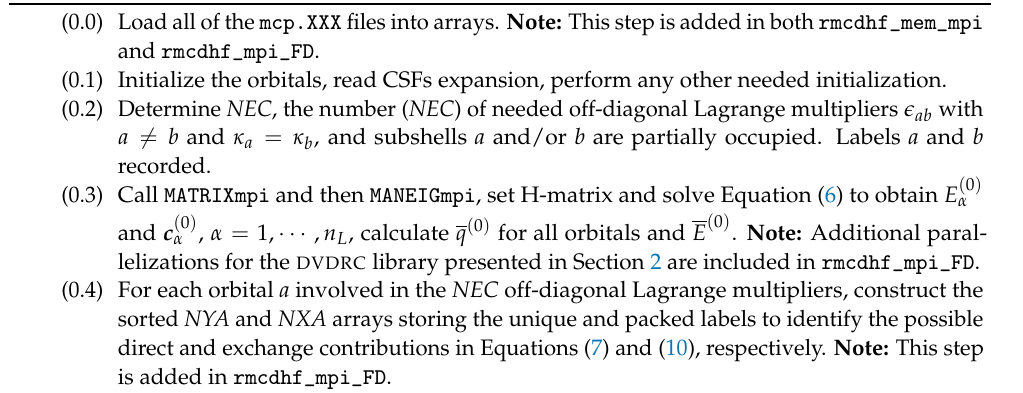
Algorithm 2: SCF